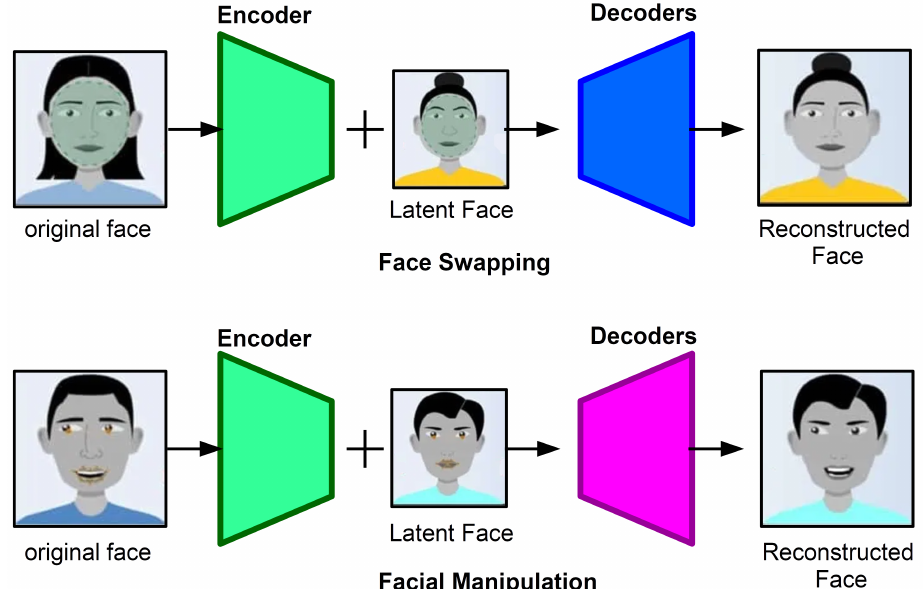
Figure 2. Process of Deepfake Creation: The original face is extracted and processed by the DNN Encoder. The latent face image with dormant features feed to DNN Decoder along with encoder input. The final reconstructed face image is produced from both images (original face and latent